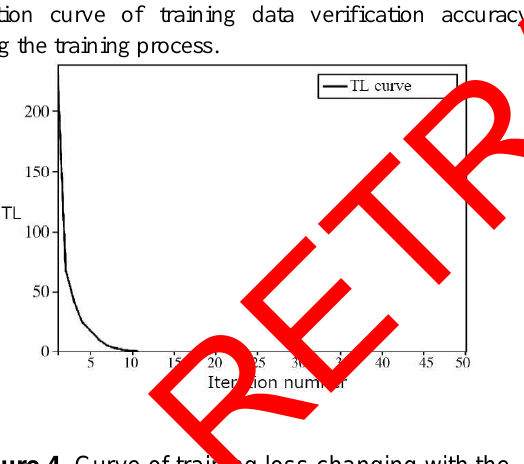
Figure 4. Curve of training loss changing with the number of iterations (here TL denotes training loss)